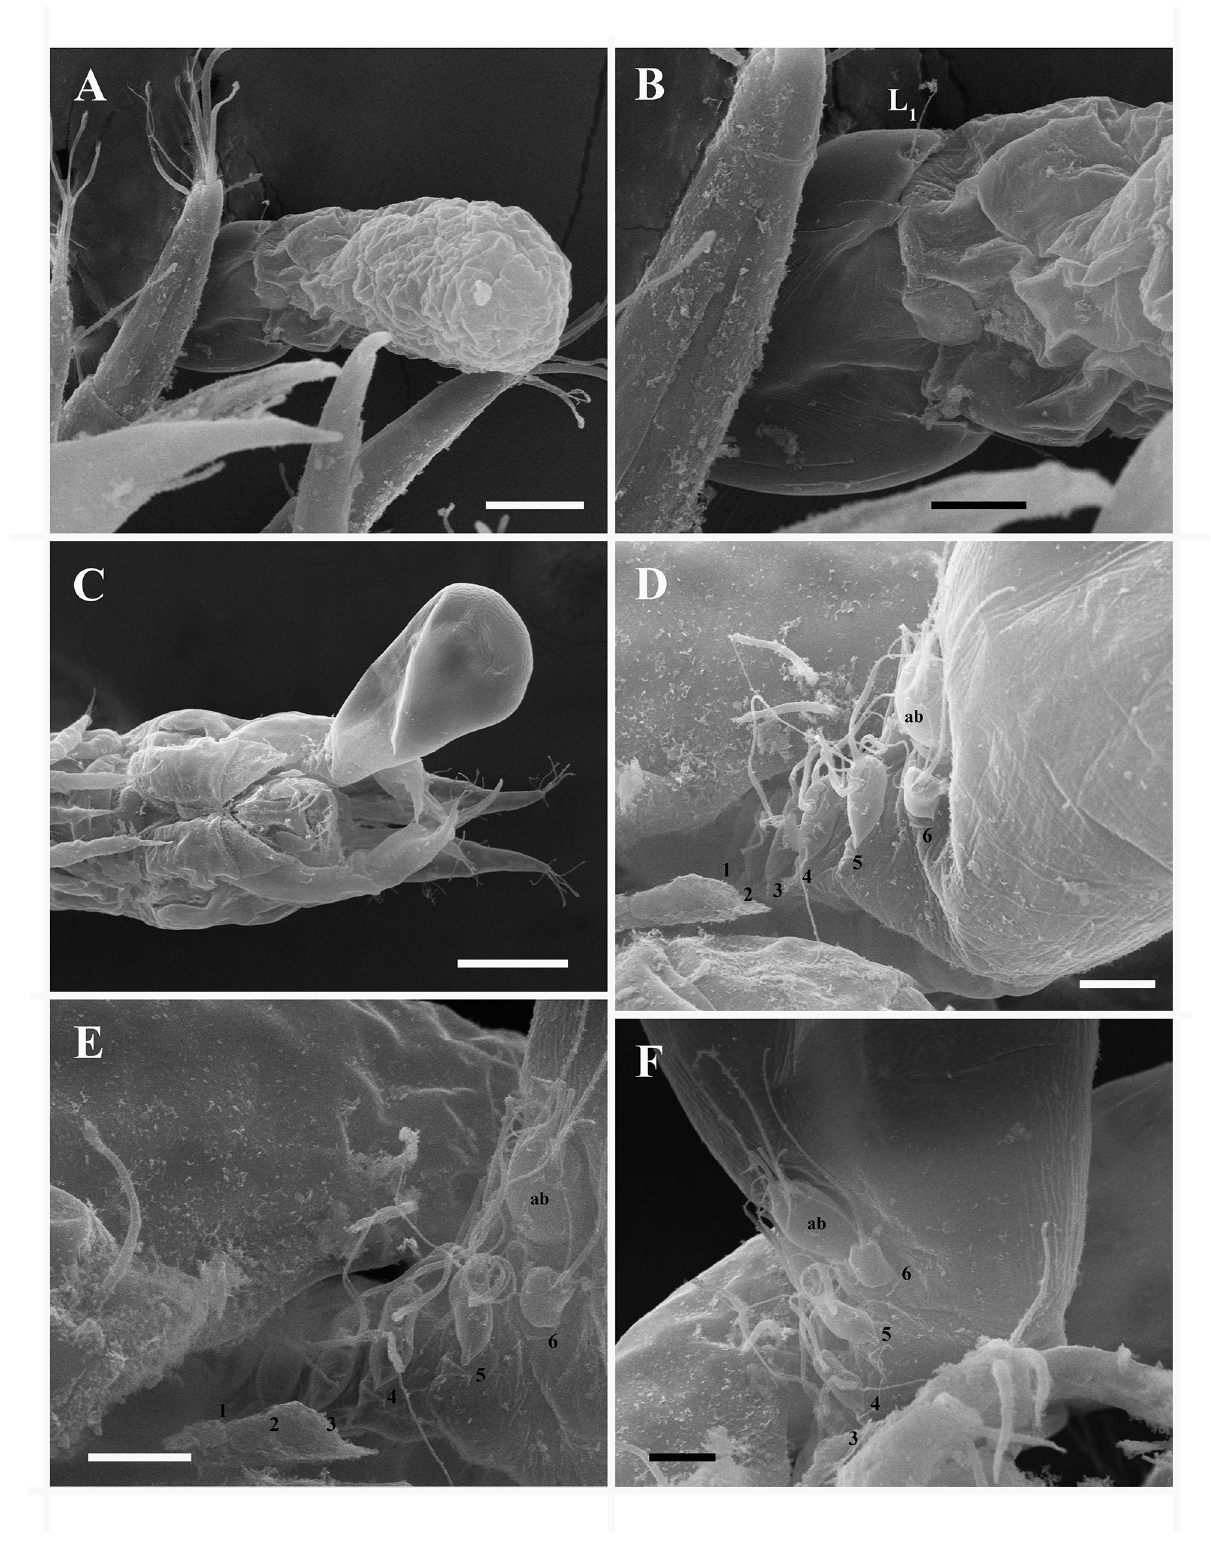
Figure 2. Microdajus sp. A , B ) Expanded tantulus larva bearing trunk sac attached to right antennule of neuter Typhlotanais sp. (1.2 mm) (USNM 1640971). C – F ) Expanded tantulus larva bearing male in sac attached to right pereopod 1 of neuter Typhlotanais sp. (1.2 mm) (USNM 1640973). A ) Ventral view. B ) Cephalon showing L cephalic pore with long setae. C ) Ventral view. 1 D – E ) Thoracopods 1–6 and abdominal segments, oblique view. F ) Thoracopods 3–6 and abdominal segments, lateral